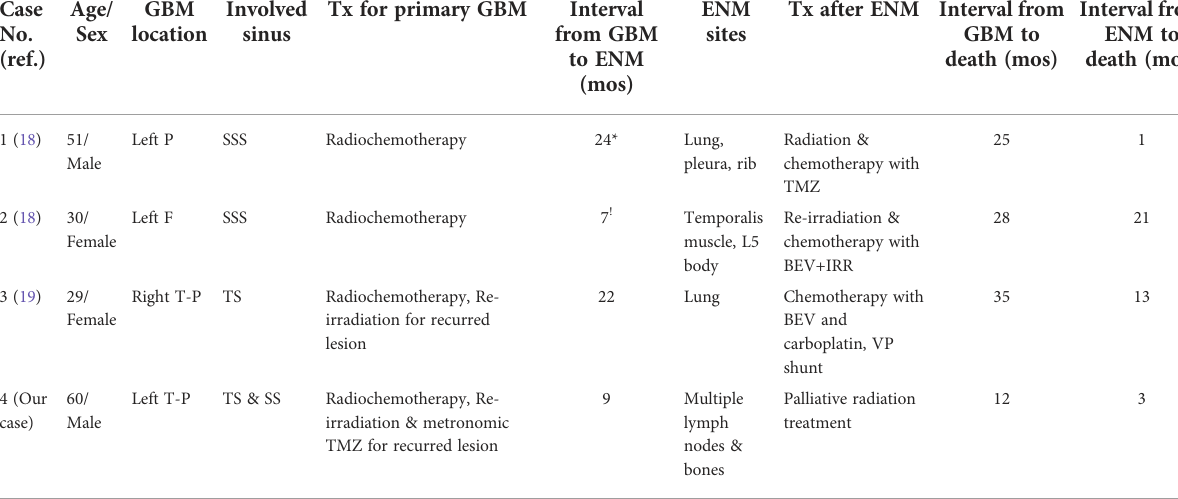
TABLE 1 Summary of recently reported glioblastoma cases with ENM through venous sinus. Case